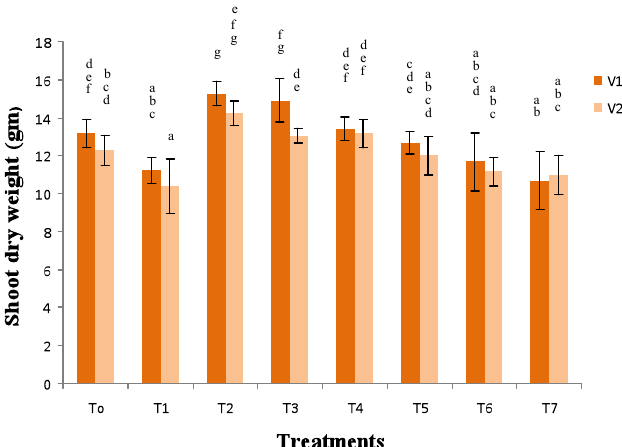
Fig. 1C: Effect of Azospirillum inoculation on shoot dry weight of two canola varieties (v1 and v2) grown under drought stress. Where, To = Un-inoculated and well watered, T = Un-inoculated and drought exposed, T2 = Seed inoculated and well watered, T3 = Rhizosphere inoculated and well watered, T4 = Seed inoculated with heat killed inoculums and well watered, T5 = Seed inoculated and drought exposed, T6 = Rhizosphere inoculated and drought ex- posed, T7 = Seed inoculated with heat killed inoculums and drought exposed. And V1 = Rainbow, V2 = Con II.